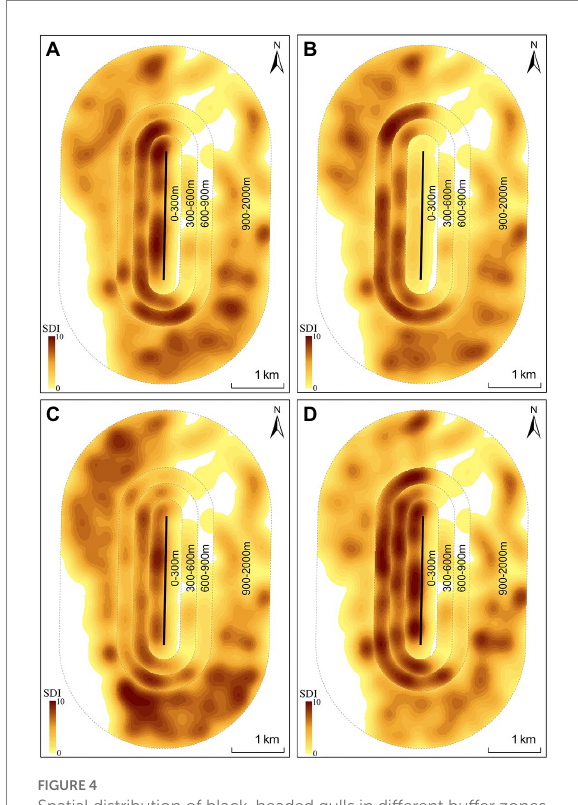
FIGURE 4 Spatial distribution of black-headed gulls in different buffer zones during four stages at Dianchi Lake, Kunming City, Yunnan Province, southwestern China ( A -SOP2019; B -SCP2019; C - SOP2020; D